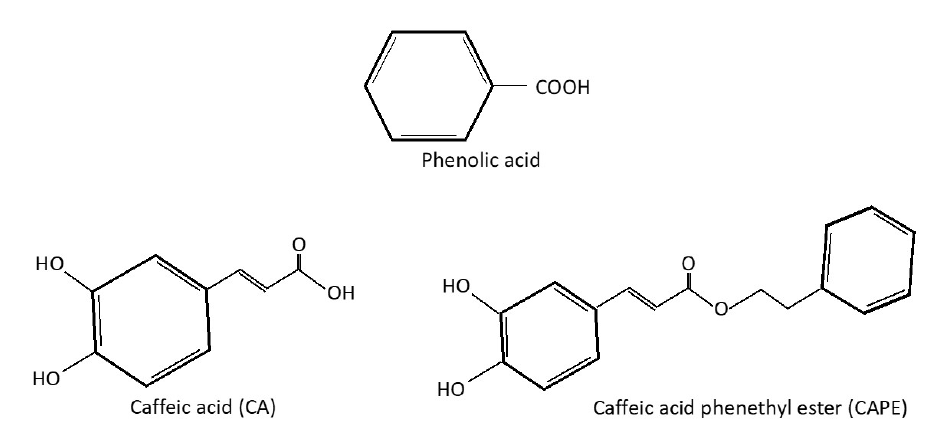
Figure 1. Chemical structure of PA, CA, and